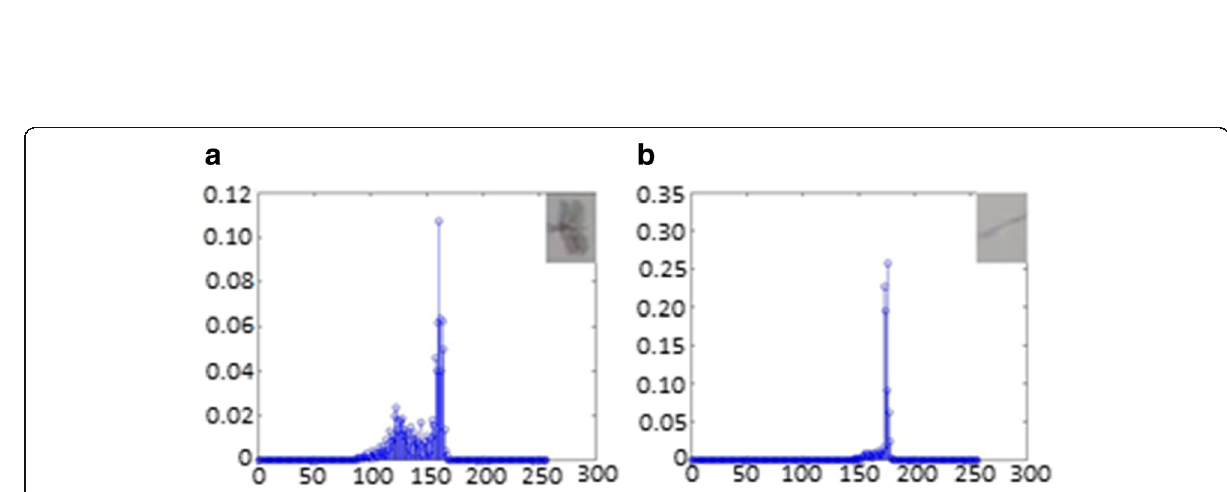
Fig. 21 Object histogram variation based on deformation, ( a ) histogram of original image ( b ) histogram of deformed image